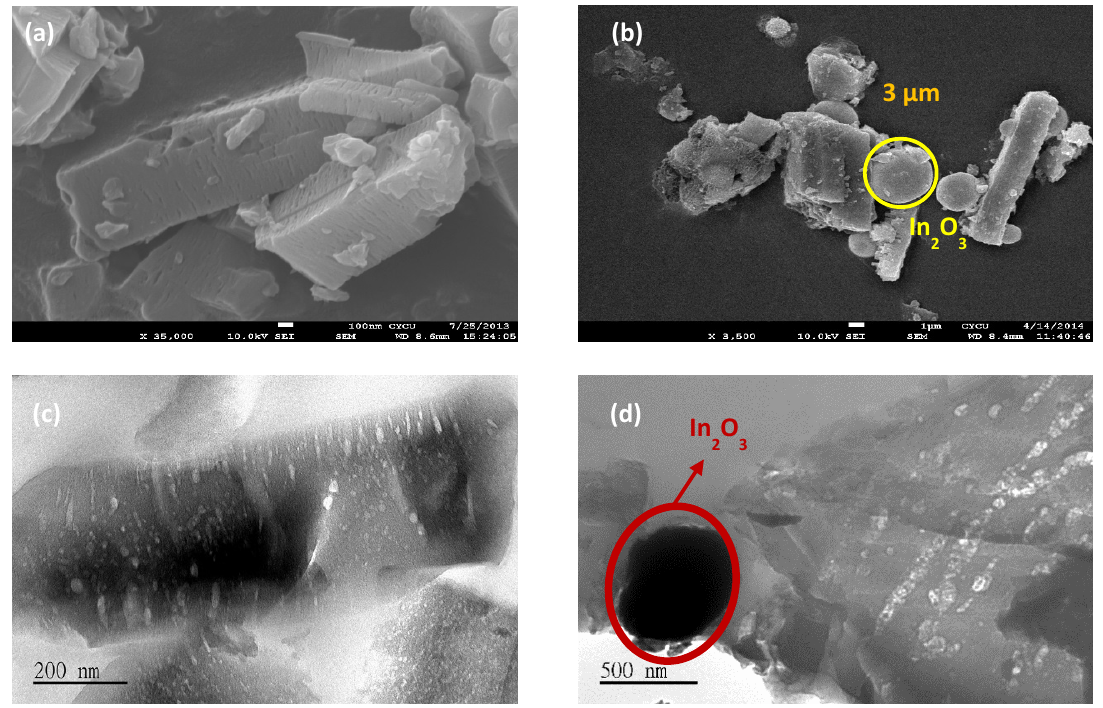
Figure 7. The SEM images of 2c ( a ), and 3c ( b ) and the TEM images of 2c ( c ), and 3c ( d ).